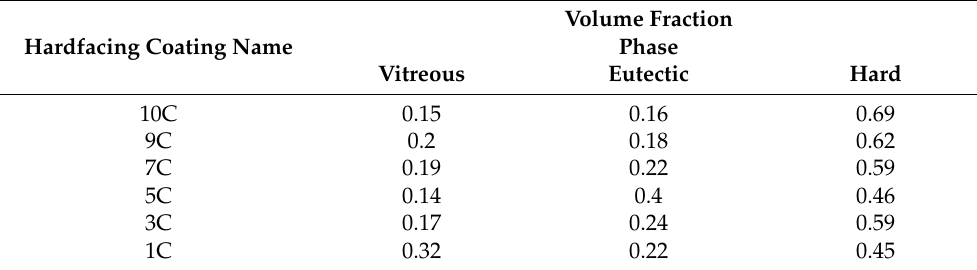
Table 6. Volumetric fractions of the phases presented in six different hardfacing coatings.